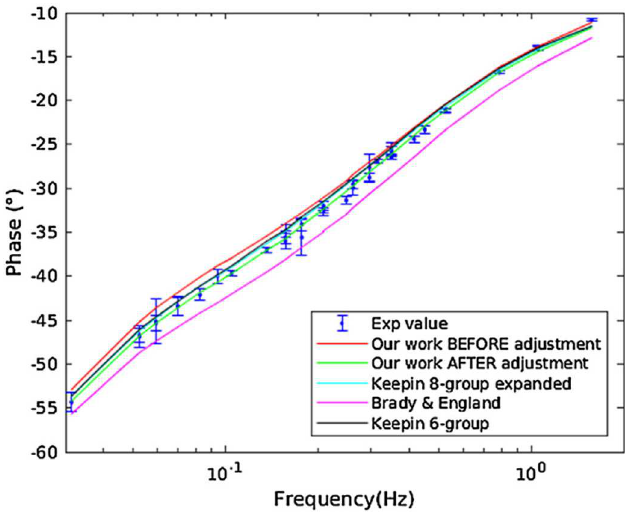
Fig. 4. ZPTF phase measured in the MINERVE reactor [54] compared with equivalent results with the kinetic parame- ters from Brady & England (ENDF/B-VIII.0 β 4 [56]), Keepin 6-group (JENDL-4.0 [57]) and Keepin 8-group expanded (JEFF- 3.3